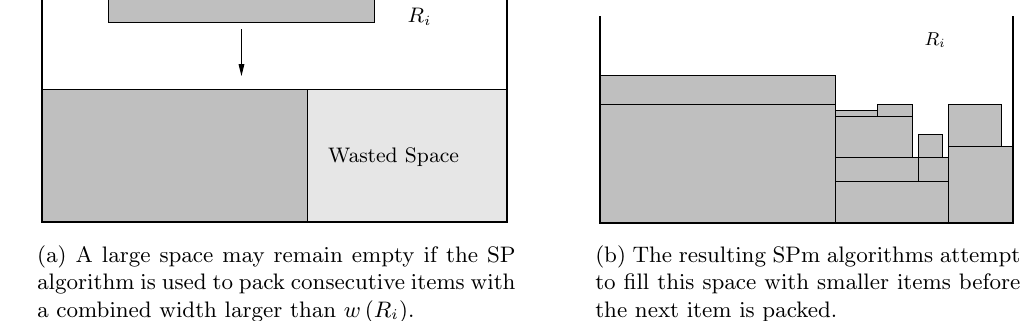
Figure 1: An illustration of the proposed modification to the SP algorithm. An attempt is made to pack smaller items adjacent to an item before another item is packed above it in region R i